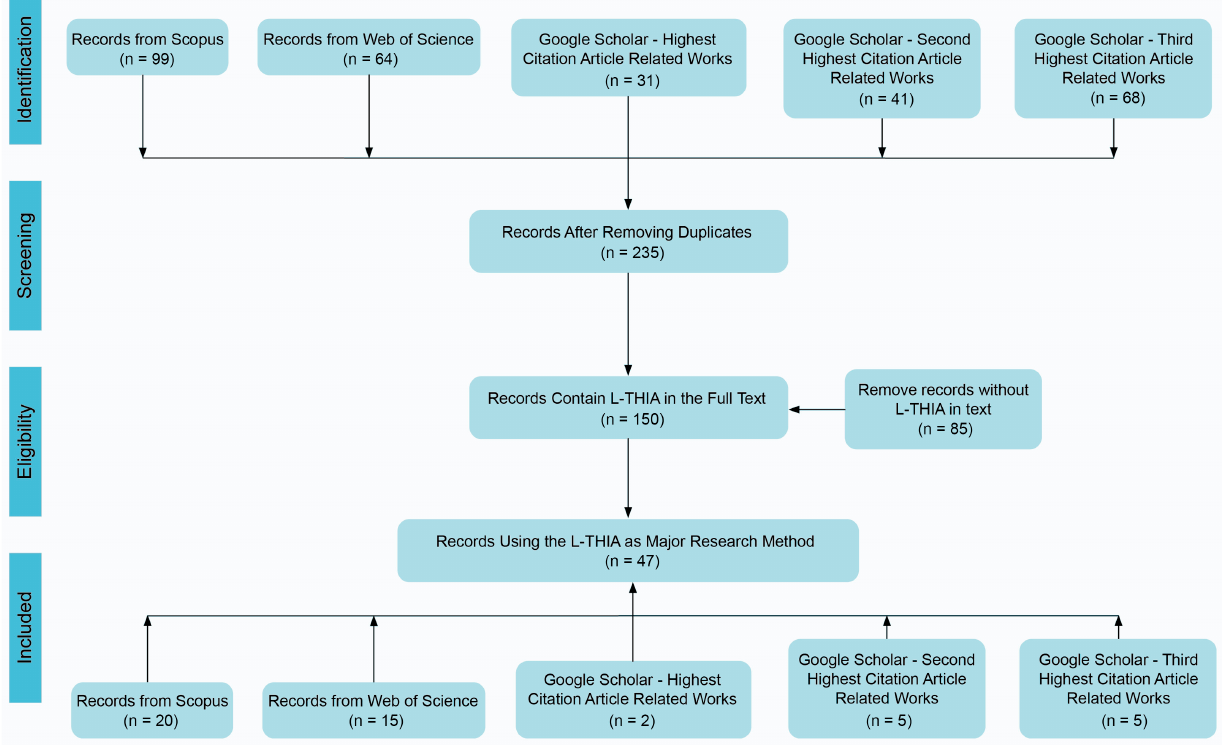
Figure 2. Process for reviewing published applications of the L-THIA and L-THIA-LID